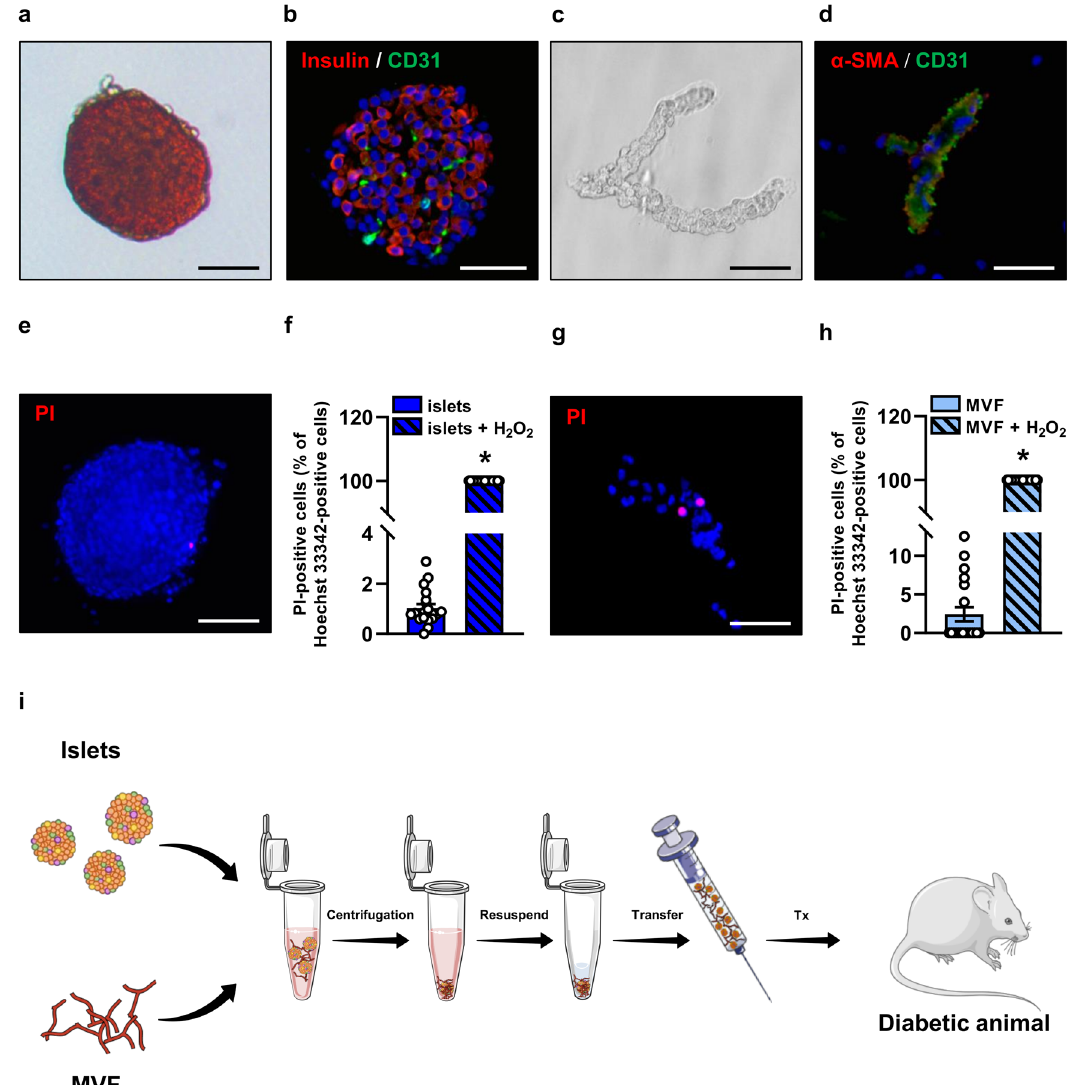
Fig. 1 Viability and transplantation of isolated islets and MVF. a Bright- fi eld microscopic image of an isolated neutral red-stained islet. Scale bar: 50 μ m. b Fluorescence microscopic image of insulin (red)- and CD31 (green)-stained islet. Cell nuclei are stained with Hoechst 33342 (blue). Scale bar: 50 μ m. c Bright- fi eld microscopic image of an isolated MVF. Scale bar: 15 µm. d Fluorescence microscopic image of an α -SMA (red)- and CD31 (green)-stained MVF. Cell nuclei are stained with Hoechst 33342 (blue). Scale bar: 15 μ m. e Fluorescence microscopic image of a PI (red)-stained islet. Cell nuclei are stained with Hoechst 33342 (blue). Scale bar: 100 μ m. f Quantitative analysis of PI-positive cells (% of all Hoechst 33342-positive cells) within islets directly after their isolation. H 2 O 2 -treated islets served as a positive control. Mean ± SEM ( n = 20 each group). An unpaired Student ’ s t test was used. * P < 0.05 vs. islets. g Fluorescence microscopic image of a PI (red)-stained MVF. Cell nuclei are stained with Hoechst 33342 (blue). Scale bar: 15 μ m. h Quantitative analysis of PI-positive cells (% of all Hoechst 33342-positive cells)